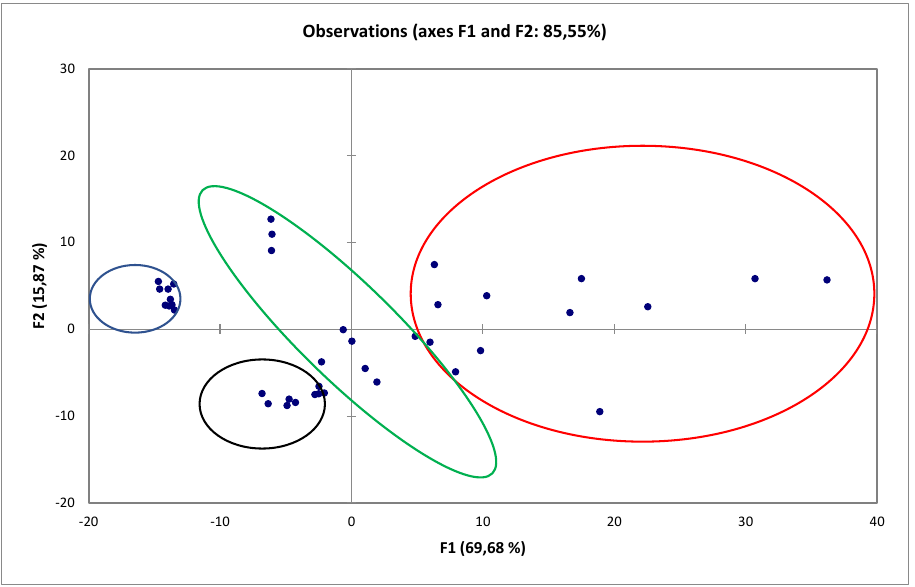
Figure 2. Observation chart: Projection of lignocellulosic biomass onto the space defined by F1 and F2 primary components. 1 (red line)—unprocessed buckwheat straw samples; 2 (green line)—biomass after EMIMCl processing; 3 (black line)—biomass after EMIMOAc and EMIM Cl processing; 4 (bright green line)—buckwheat straw after processing with EMIMDEP, and 5 (blue line)—buckwheat straw after EMIMOAc processing.